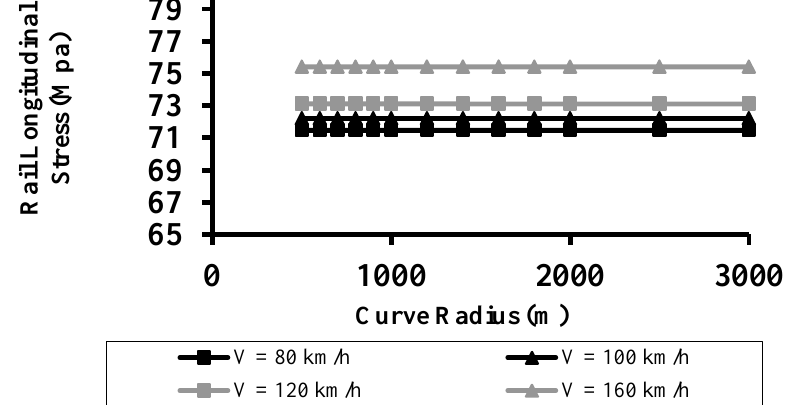
Fig. 6. Longitudinal stress variation along UIC60 rail for different curve radiuses and